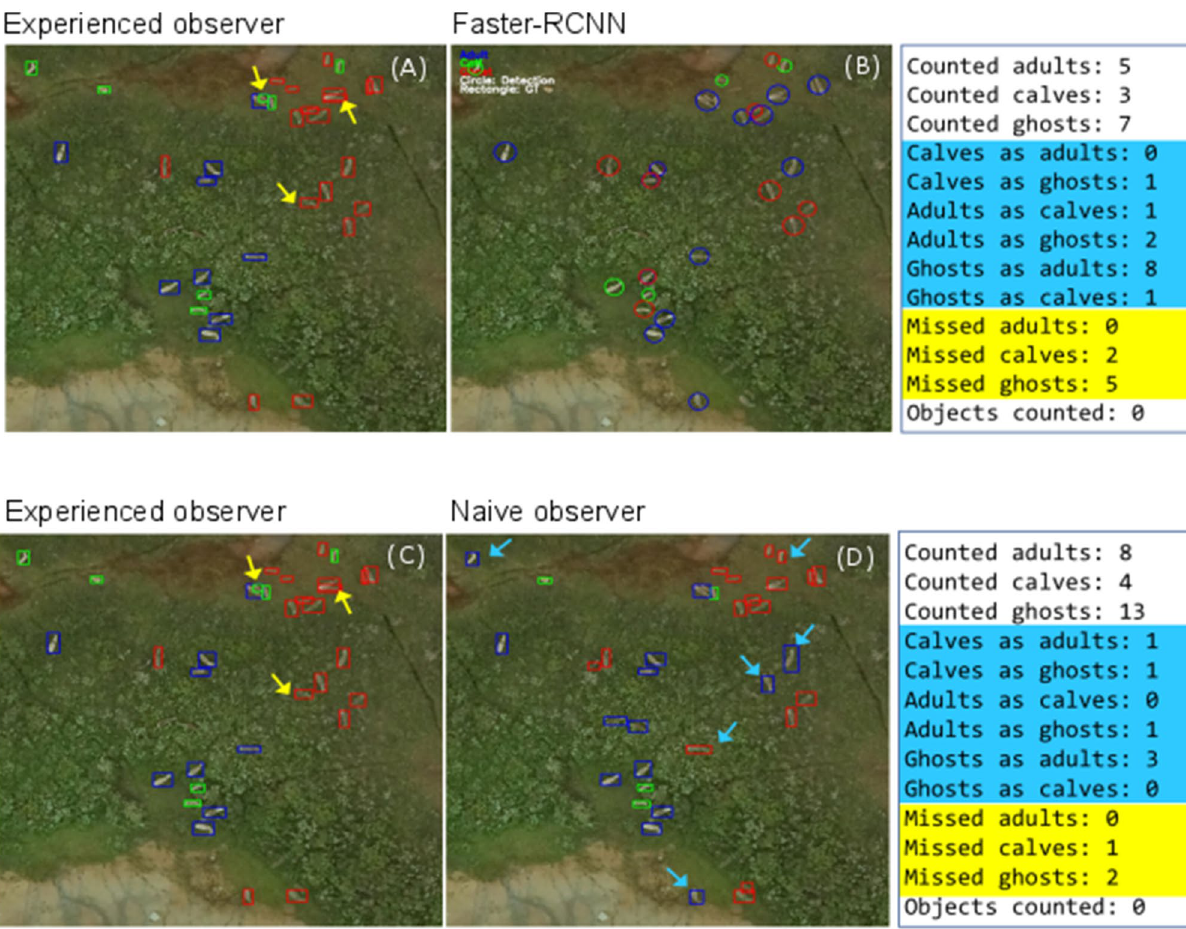
Figure 3. Example of comparison of experienced observer counts ( A , C ) with the Faster-RCNN ( B ) and naïve observers ( D ). Blue arrows indicate misclassifications and yellow arrows missed individuals. Note that at the Faster-RCNN image, detection of an adult and a ghost are overlapped. Counted adults are the true positives, misclassifications are false positives, and missed individuals are false negatives. Figure was assembled using Affinity Designer v 1.9.1.979 (https:// affin ity. serif.